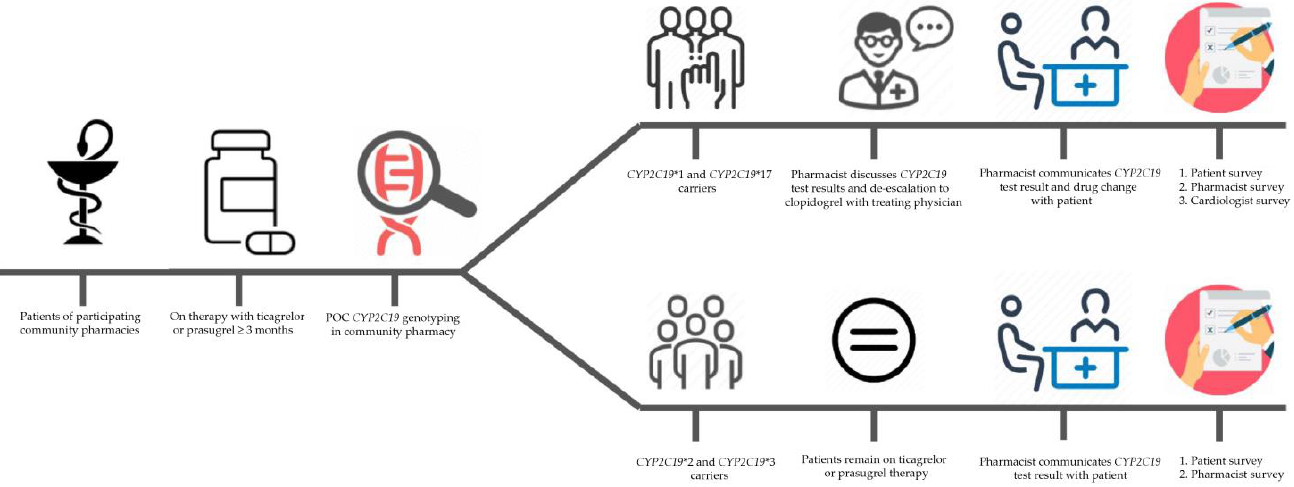
Figure 1. Patient and pharmacist journey per study patient undergoing POC (POC) CYP2C19 testing in the community pharmacy. Patients of participating community pharmacies with an indication for ticagrelor or prasugrel for at least three months are recruited by their community pharmacist. After informed consent, patients are genotyped for CYP2C19 *2, *3, and *17 in the community pharmacy. Patients with only CYP2C19 *1 and *17 allele are eligible for antiplatelet therapy de-escalation and switched to clopidogrel in consultation with treating cardiologist. Upon cardiologist’s approval, pharmacists communicate therapy de-escalation to clopidogrel with patients. Patients with a loss- of-function (LOF) CYP2C19 *2 or *3 polymorphism remain on ticagrelor or prasugrel antiplatelet therapy. All CYP2C19 test results are communicated with the patients by the pharmacist. All (1) patients with a CYP2C19 test result, (2) participating pharmacists, and (3) treating cardiologists- who have been approached by pharmacists for de-escalation to clopidogrel- are invited to partici- pate in a general survey on POC CYP2C19 testing in the community pharmacy. 2.7. Cost Analysis We estimated average net costs per patient due to POC CYP2C19 testing, which was presented in euros at price level 2023. Variables used to calculate cost savings per patient were de-escalation rate, therapy duration of P2Y 12 inhibitor, percentage of patients on chronic P2Y 12 inhibitor treatment, percentage of patients eligible for DAPT de-escalation, and ticagrelor-prasugrel ratio of study population. For costs of PGx testing, the supplier- provided list price of POC device and ancillary test kits was used. Drug costs per day were valued at €0.05 for clopidogrel (75 mg), €1.23 for prasu grel (5 mg), €2.38 for non -chronic ticagrelor (2 × 90 mg), and €2.48 for chronic ticagrelor (2 × 60 mg) [5]. Costs related to efficacy and safety events were excluded from the analysis due to the feasibility nature of our study. Costs per prevented major or minor bleeding according to the PLATO defini- tion [35] were calculated based on the number of de-escalated patients needed to prevent one such bleeding. This number was set at 37, since the POPular Genetics Trial estimated that de-escalation reduces the PLATO major or minor bleeding risk from 12.5% to 9.8% [14]. The full spreadsheet model is presented in Supplementary Material File S2 Cost Analysis.